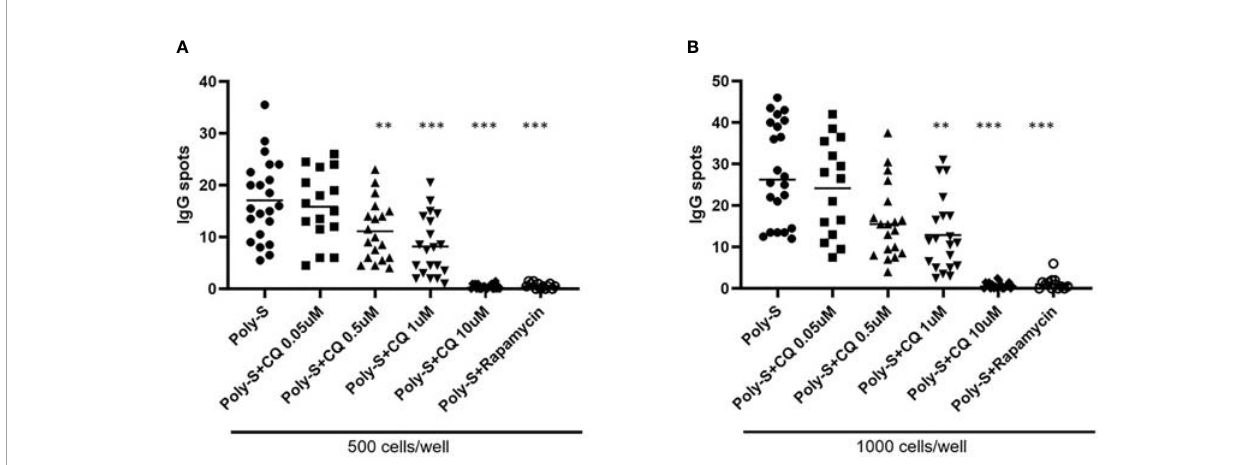
FIGURE 7 | Effect of CQ on IgG-secretion of plasma cells derived from renal transplant patients. To further investigate the effect of CQ on B-cells from renal transplant patients, 22 patients were enrolled. Isolated CD19 + B cells derived from renal transplant patients were seeded at a concentration of 5 × 10 4 cells/well under Poly-S stimulation in presence of CQ for 4 days. B cells were then harvested and transferred to ELISpot plates at a density of 500 or 1000 cells/well for further 24 hours. (A) Impact of CQ on IgG-secretion of plasma cells at a density of 500 cells/well. (B) Impact of CQ on IgG-secretion of plasma cells at a density of 1000 cells/well. P-values were calculated by repeated-measures ANOVA and correction for multiple comparisons were done by Dunnett ’ s test. **p < 0.001, ***p < 0.0001 (against Poly-S as control